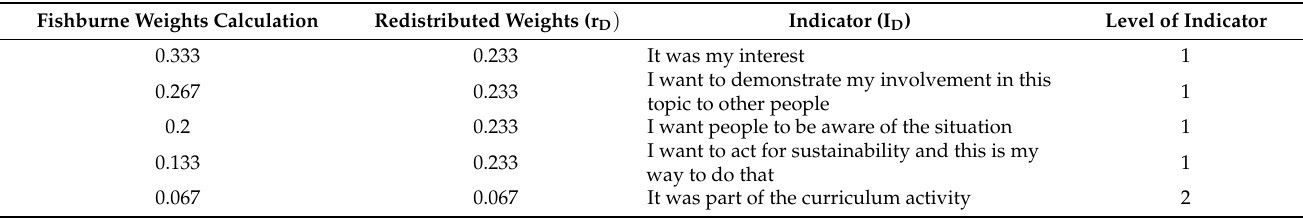
Table 28. Reasoning indicators for discussion.